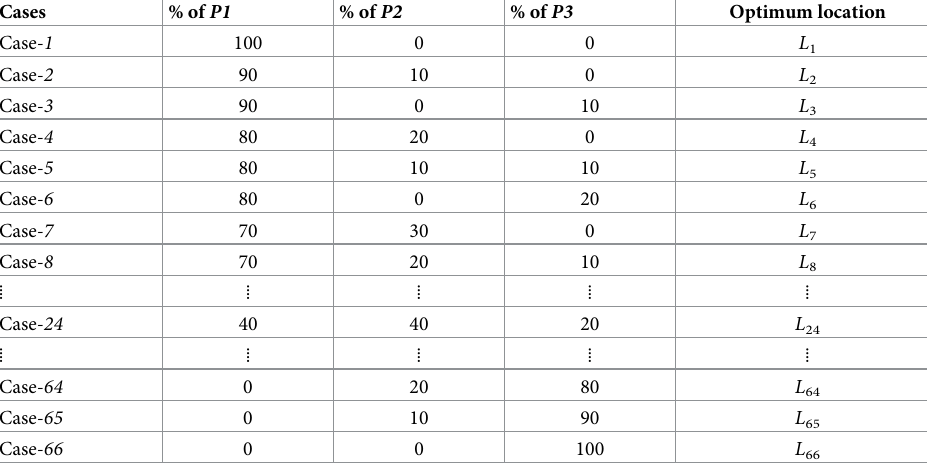
Table 5. Cases established using percentage